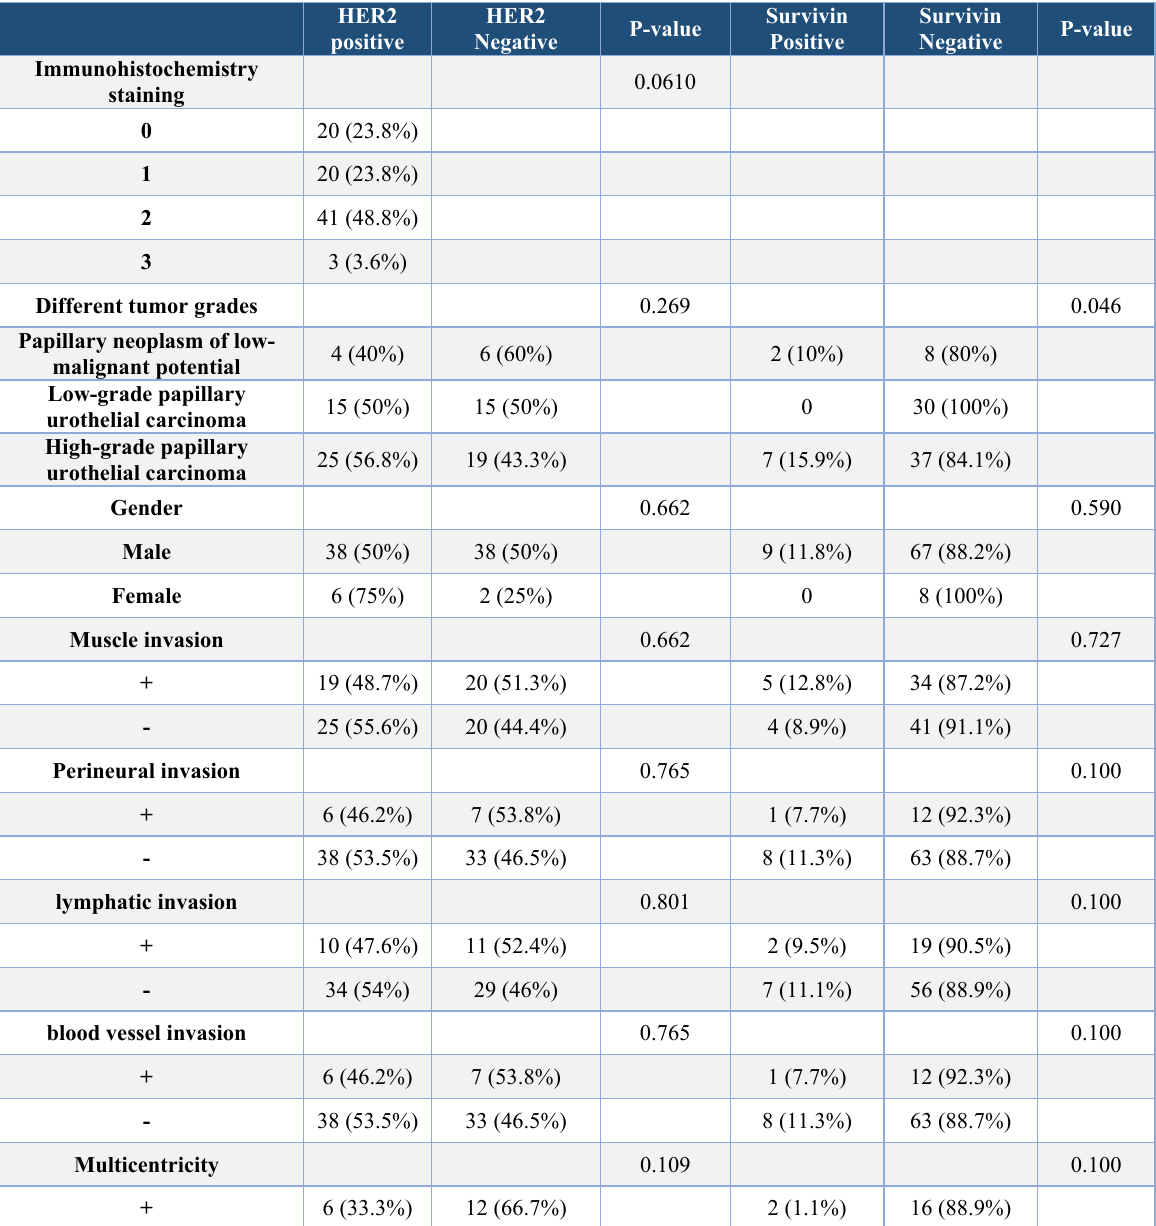
Table 3. Positive and negative HER2 and Survivin markers frequency